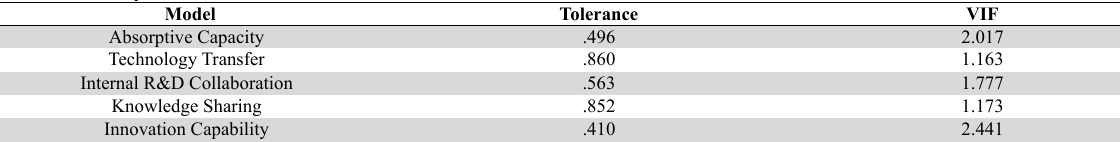
Multicollinearity